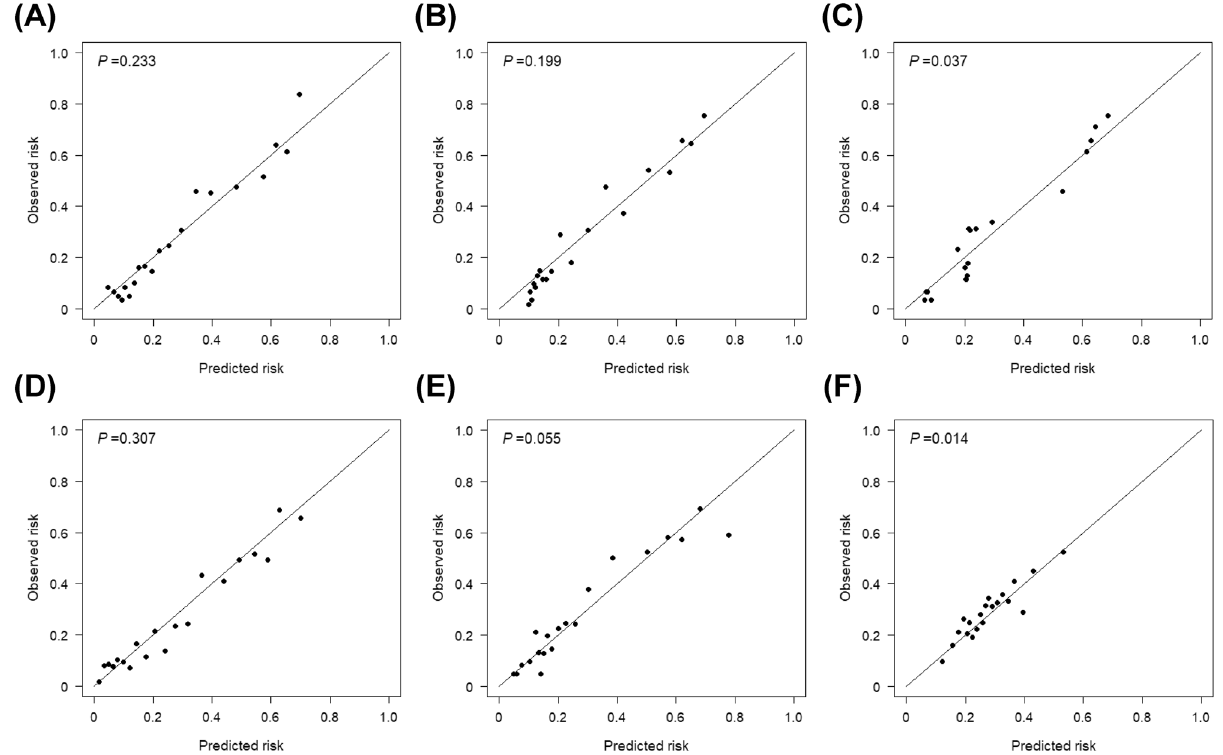
Figure 3. Calibration plots of the light gradient boosting machine ( A ), extreme gradient boosting ( B ), support vector machine ( C ), random forest ( D ), logistic regression-scoring ( E ), and simple postoperative acute kidney injury risk ( F ) models. P values more than 0.05 indicate good